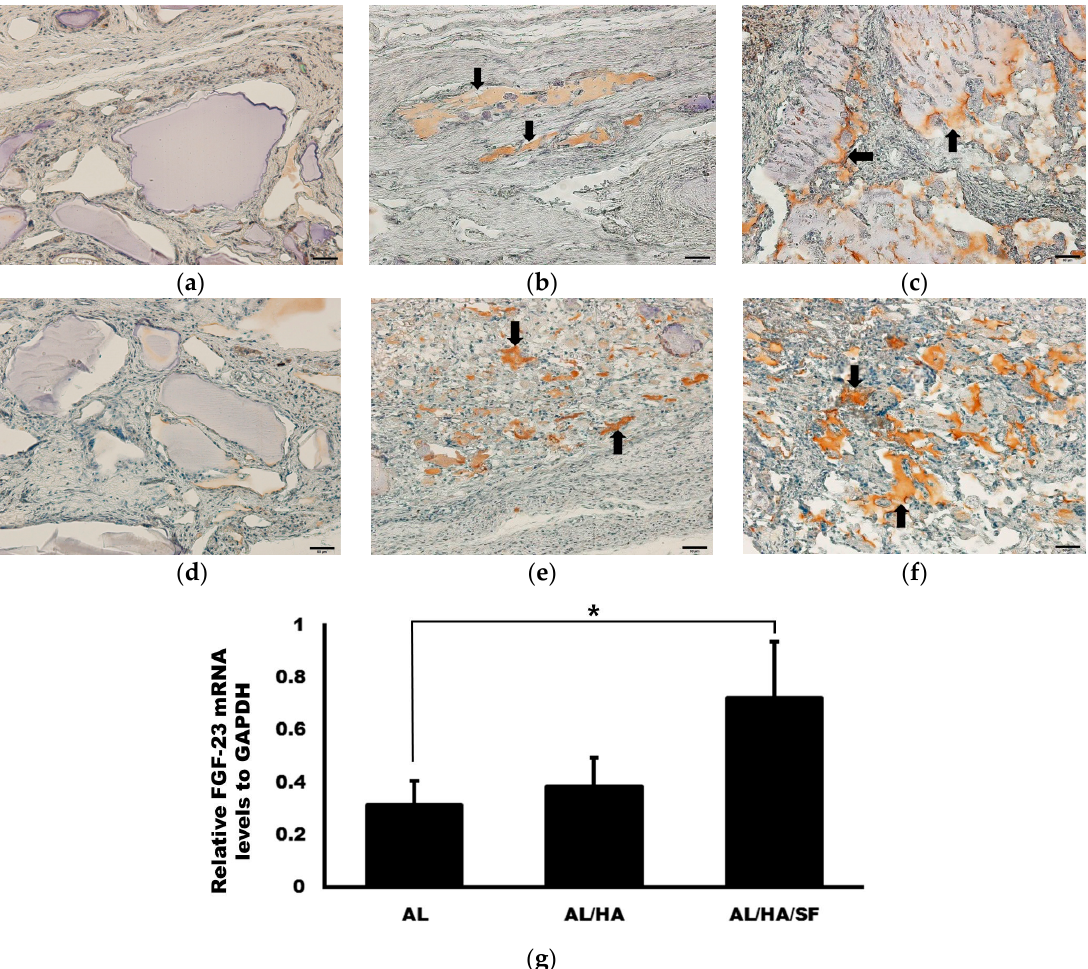
Figure 7. Immunohistochemical staining for osteoprotegerin (OPG) ( a – c ) and Runx2 ( d – f , original magnification, 200×, bar = 50 µm) and qRT-PCR of FGF-23 mRNA at 8 weeks after operation. TNF- α positive area was indicated as arrows. ( a , d ) AL group; ( b , d ) AL/HA group; ( c , f ) AL/HA/SF group; ( g ) Significantly higher FGF-23 expression was observed in the AL/HA/SF group compared with that in the AL group (* p = 0.044, respectively).